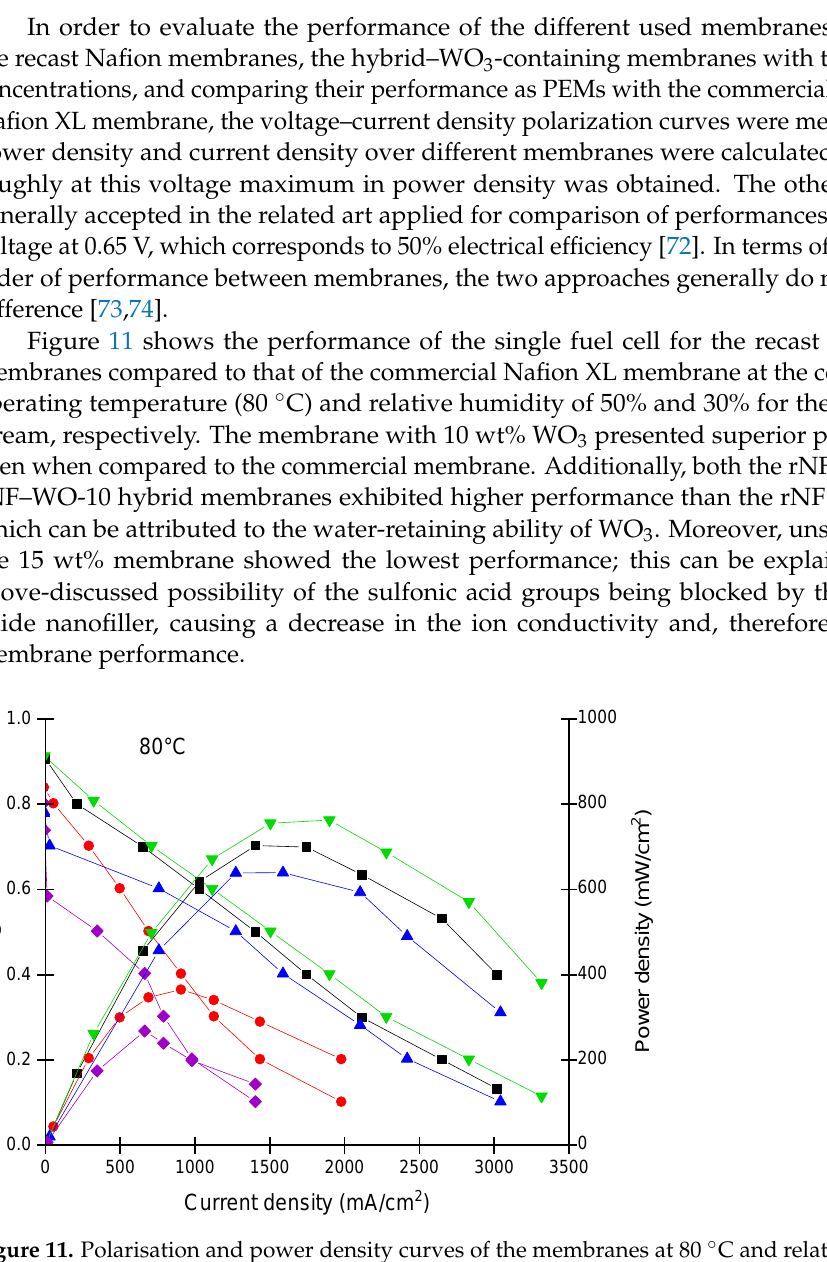
Figure 11. Polarisation and power density curves of the membranes at 80 ◦ C and relative humidity of 50% and 30% for H 2 and O 2, respectively. Nafion XL commercial membrane (black), recast Nafion membrane (red), and Nafion membrane with 5, 10, and 15 wt% tungsten oxide (blue, green, and purple,